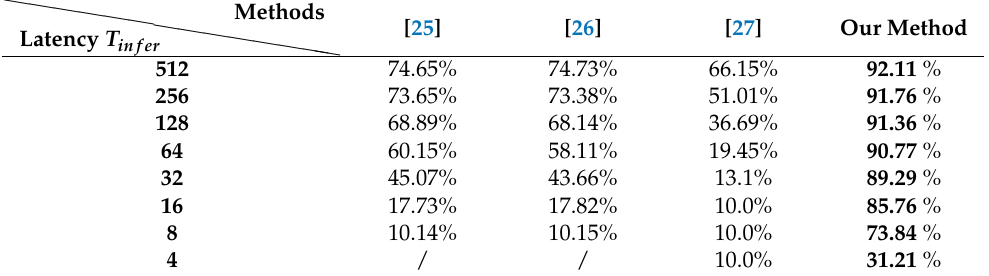
Table 3. Classification accuracies vs. latencies for the compared methods on the Fashion-MNIST dataset. (cid:104)(cid:104)(cid:104)(cid:104)(cid:104)(cid:104)(cid:104) (cid:104) (cid:104)(cid:104) (cid:104)(cid:104) (cid:104)(cid:104) Latency T